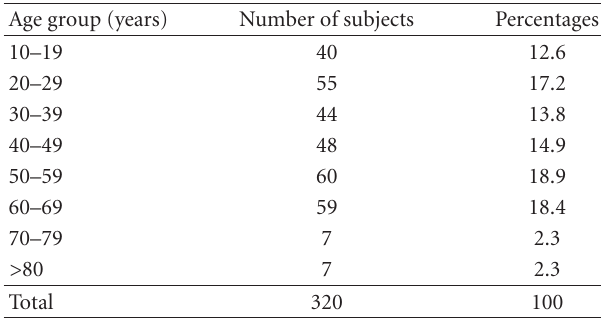
Table 1: Showing the age distribution of subjects.